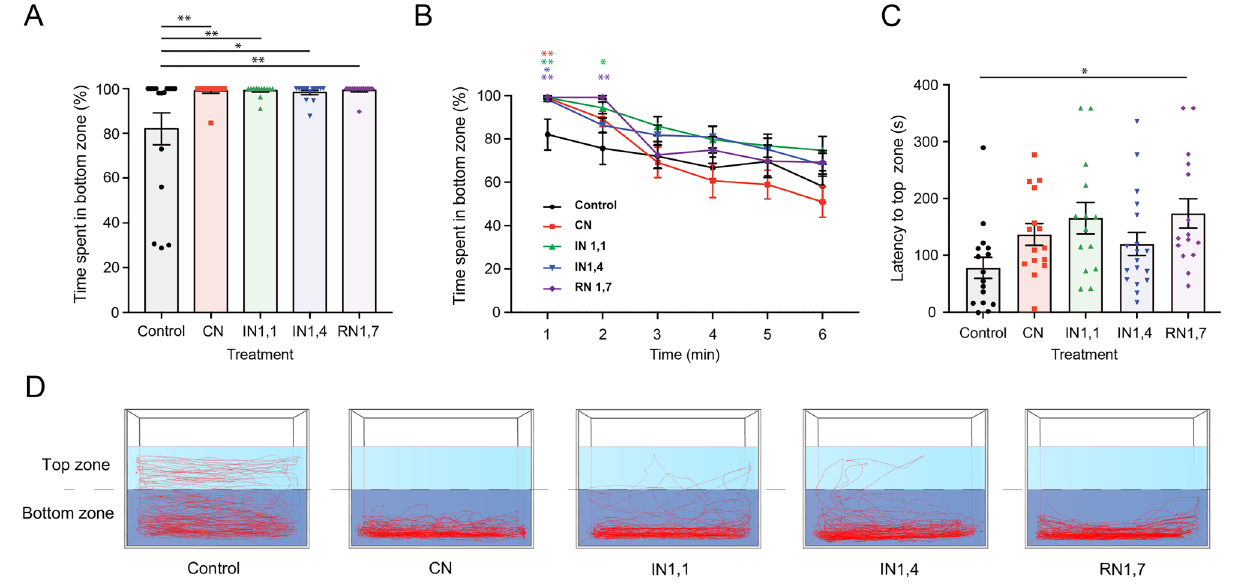
Figure 5. ( A ) Comparison of time spent in the bottom zone (Novel Tank Diving test) by zebrafish adults during the first minute between noise treatment groups (F 4,73 = 4.930, P = 0.0014). ( B ) Changes in total time spent in the bottom zone (F 4,73 = 2.771, P = 0.033) and across several time points (F 3.3,238 = 38.89, P < 0.0001). ( C ) Comparison of movement latency reaching the top zone of specimens previously exposed to different acoustic treatments (F 4,73 = 2.947, P = 0.026). ( D ) Diagrams showing merged tracking of the first minute of all tested individual fish in the NTD experimental tank (CN: continuous noise; IN1,1: intermittent noise with 1 s pulses and 1 s